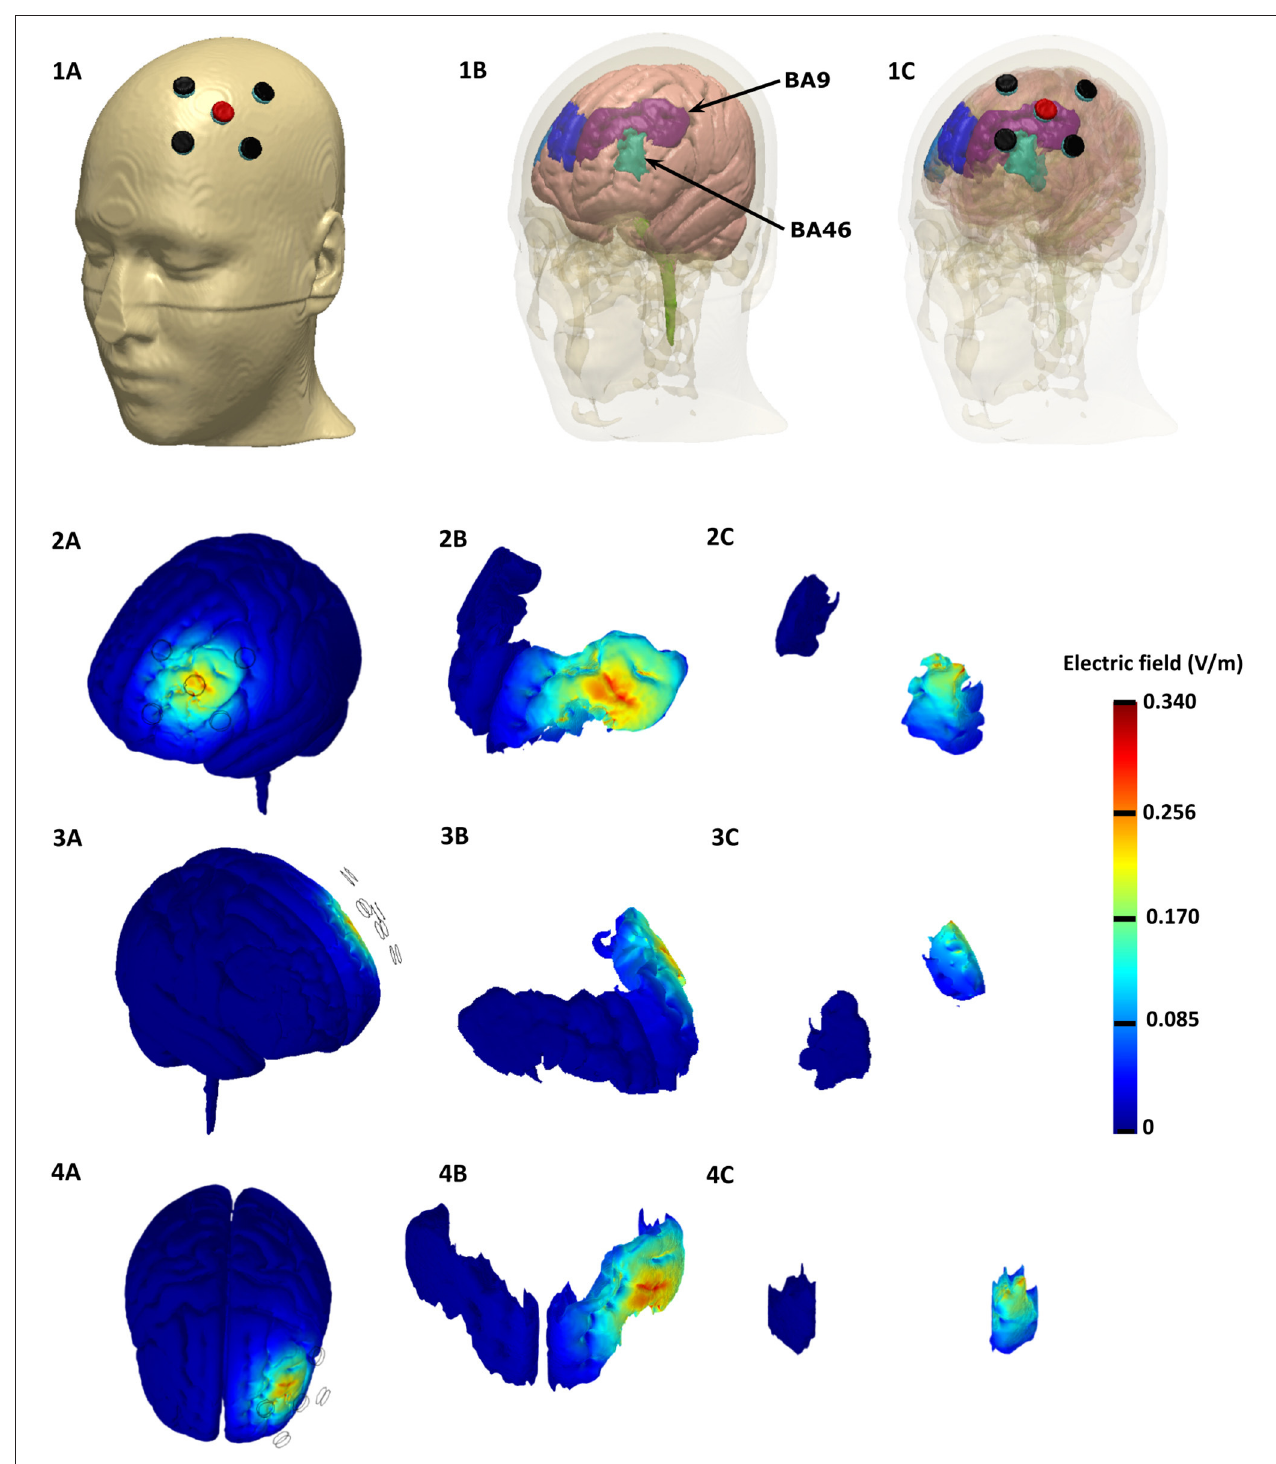
FIGURE 2 | Finite element Model of the HD-tDCS Montage based on the representative MNI 152 template, Top row: Top row: Electrode Montage considered with anode depicted in red and the cathodes depicted in black (left). The underlying brain tissue mask with the individual Brodmann areas regions is depicted in the middle: left BA 9 (purple), left BA 46 (light green), right BA 9 (blue), and right BA 46 (light blue). The HD-tDCS montage in relation to the underlying gray matter and BA masks are shown on the right. Rows 2 − 4: Induced electric field magnitude plots (left side, right side, and top views). We plotted the whole brain in the first column, BA 9 in the middle, and BA 46 in the